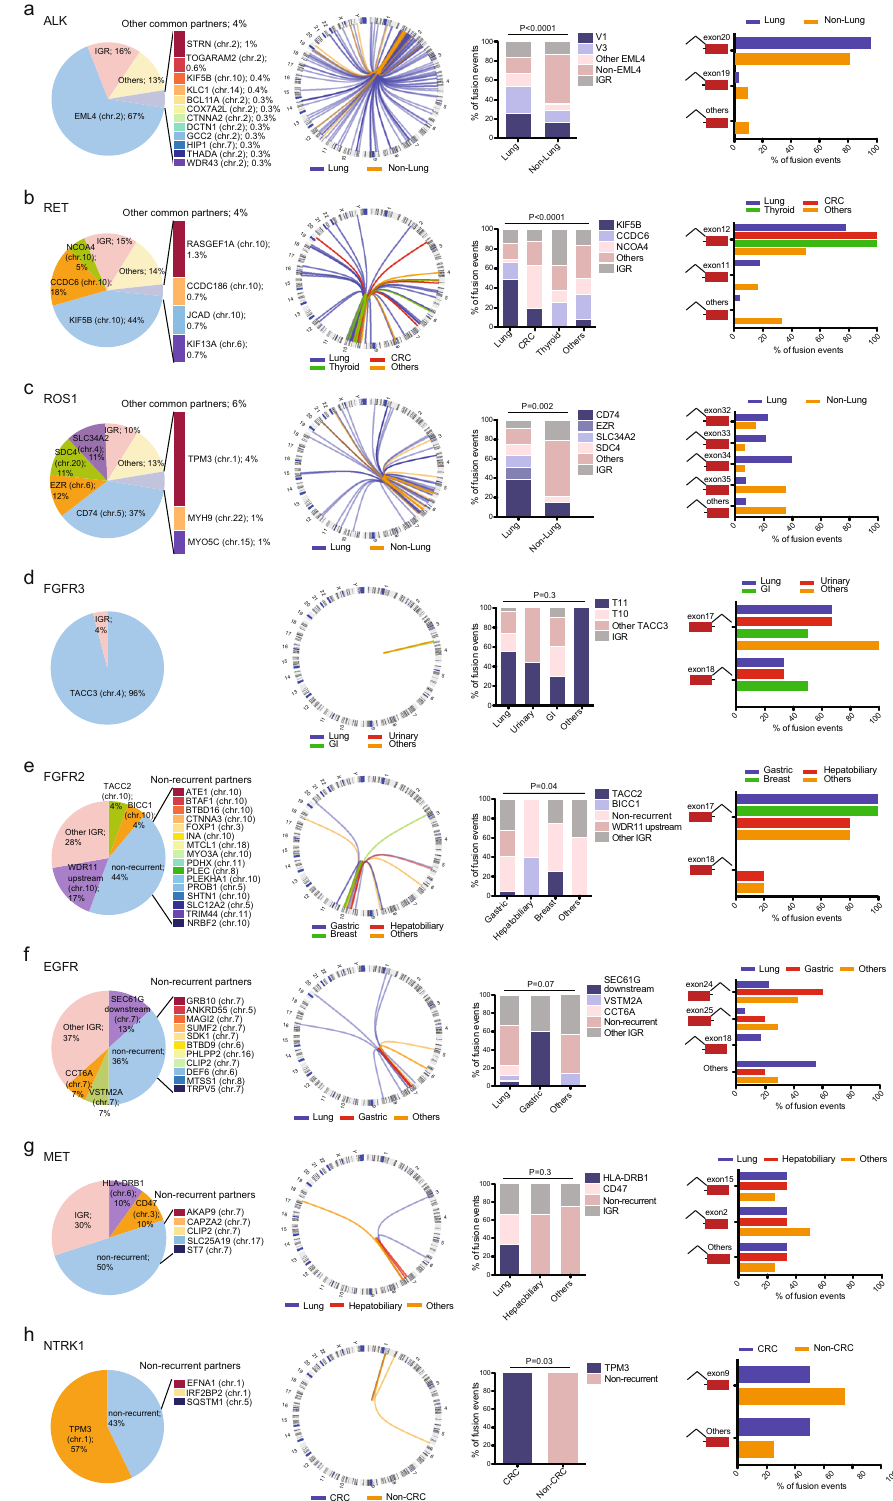
Fig. 2 Genomic structures of the common RTK fusion genes. a – h From left to right: Distributions of common fusion partners; Circos plot showing the genomic rearrangement events in different cancer types; Comparisons of fusion partner frequencies in different cancer types, P values using chi-square tests are as indicated; Comparisons of RTK breakpoints in different cancer types in a ALK , b RET , c ROS1 , d FGFR3 , e FGFR2 , f EGFR , g MET , and h NTRK1 positive samples. IGR intergenic